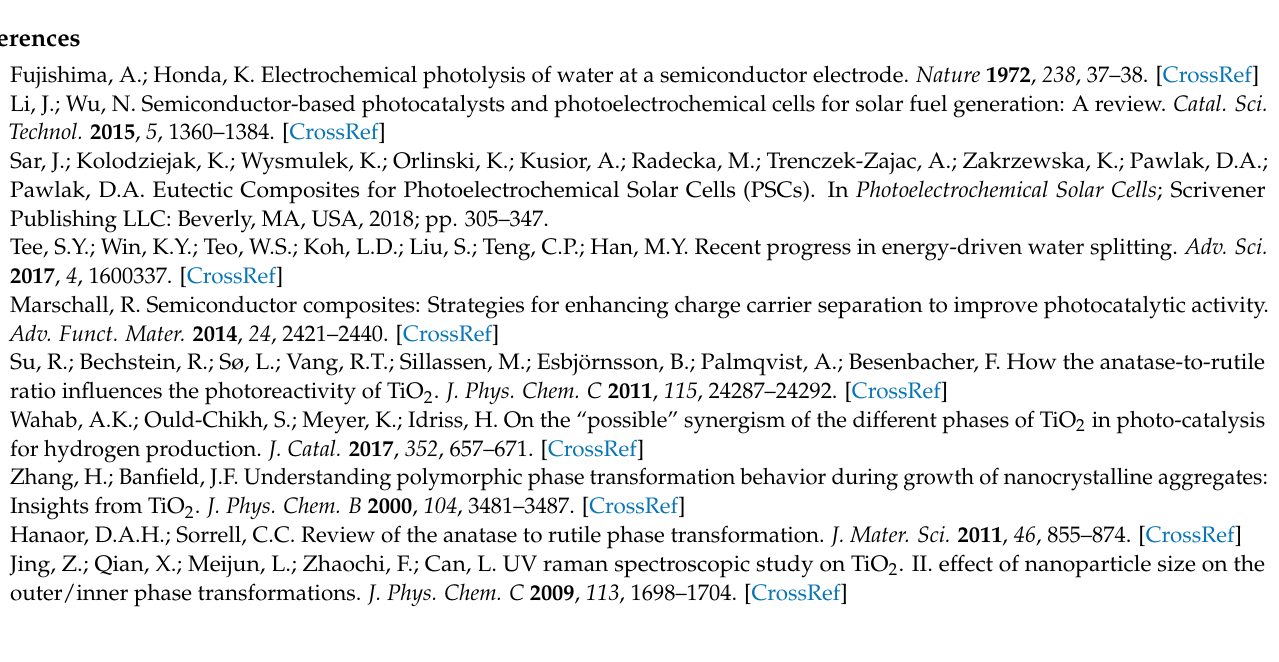
atmosphere. Figure S2. Reflectance spectra R diff for 3D flower-like nanostructures after annealing in argon and the air at (a) 450 and (b) 600 ◦ C. Table S1. Optical bandgap values for flower-like 3D nanostructures annealed at various